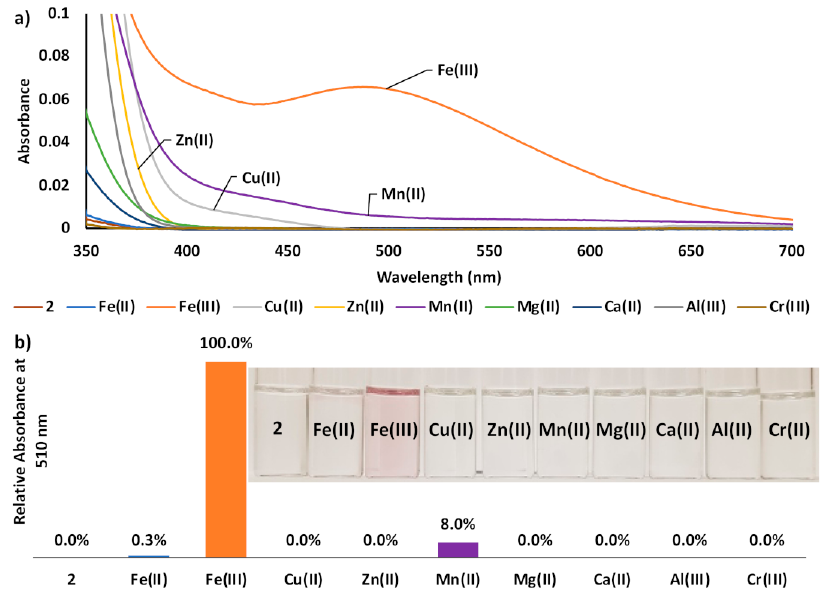
Figure 4. ( a ) Absorbance spectra of 30 µ M 2 recorded in the presence of 50 µ M of various test di- and trivalent metal cations in water at pH 3. ( b ) Relative absorbance at 510 nm for each metal cation solution and photos of the corresponding